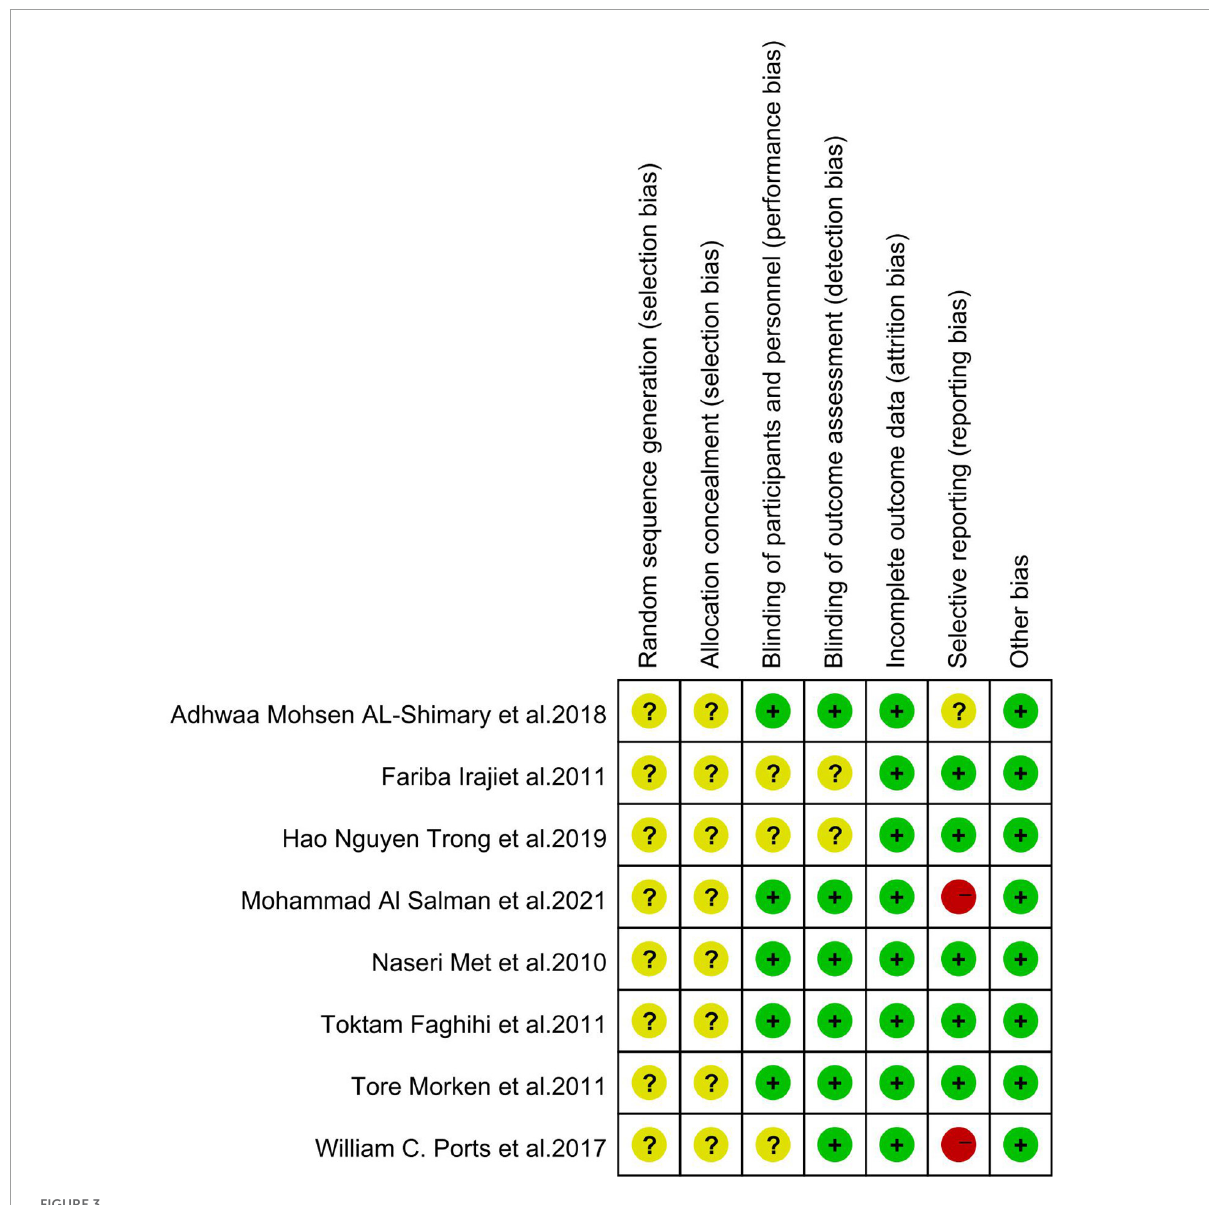
FIGURE3 Risk of bias summary of clinical